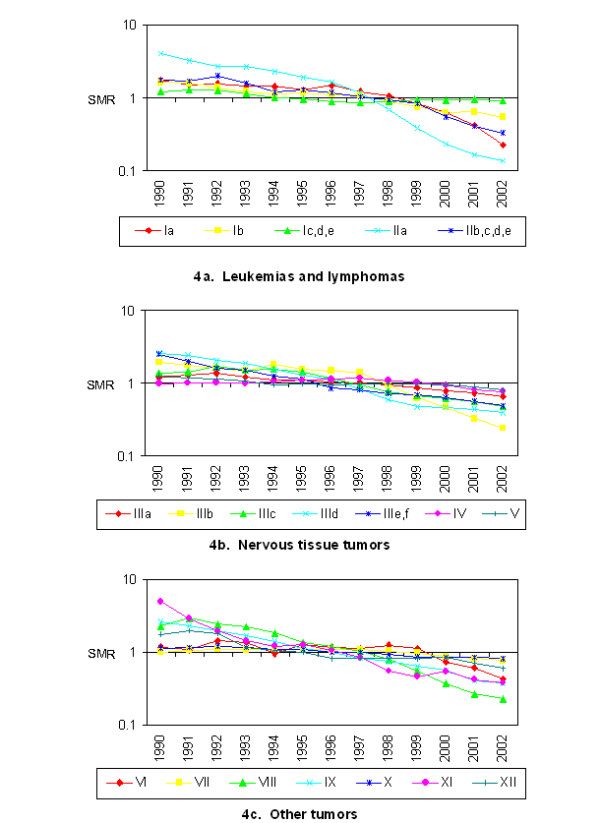
Study-specific temporal effects. 4a. Leukemias and lymphomas. 4b. Nervous tissue tumors. 4c. Other tumors. International Classification of Childhood Cancer (ICCC3) Classification Key. Ia. Acute Lymphoid leukemias (ALL). Ib. Acute myeloid leukemias (AML). Ic, d, e, Other leukemias. IIa. Hodgkin lymphoma. IIb, c, d, e. Non-Hodgkin lymphoma. IIIa. Ependymoma and choroid plexus tumor. IIIb. Astrocytomas. IIIc. Intracranial and intraspinal embryonal tumors. IIId. Other gliomas. IIIe, f Other CNS tumors. IV. Neuroblastoma and other peripheral nervous cell tumors. V Retinoblastoma. VI. Renal tumors. VII. Hepatic tumors. VIII. Malignant bone tumors. IX. Soft tissue and other extraosseous sarcomas. X. Germ cell tumors, trophoblastic tumors, and neoplasms of gonads. XI. Other malignant epithelial neoplasms and malignant melanomas. XII. Other and unspecified malignant neoplasms (including uncoded).